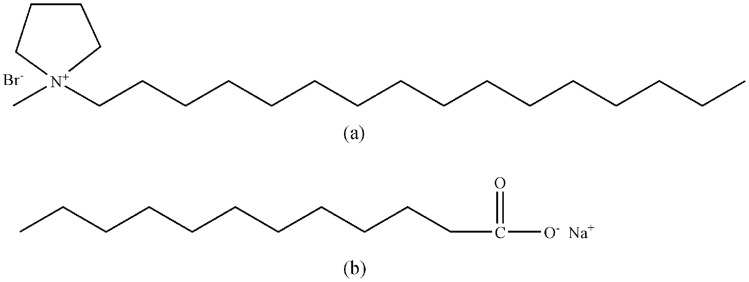
Chemical structure of C16MPBr (a) and Sodium Laurate (b).